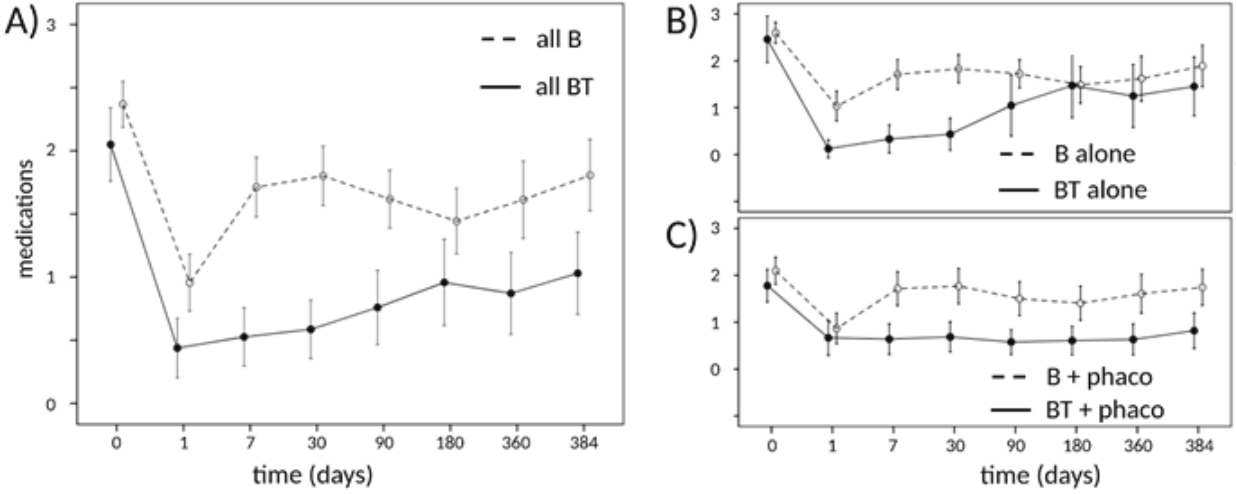
Figure 3. Preoperative and postoperative mean eyedrops for BT and B. Mean pre- and postoperative glaucoma medications for subgroup analysis separated by glaucoma surgery only (B) and same session phacoemulsification (C). Represented as mean ± 95% confidence